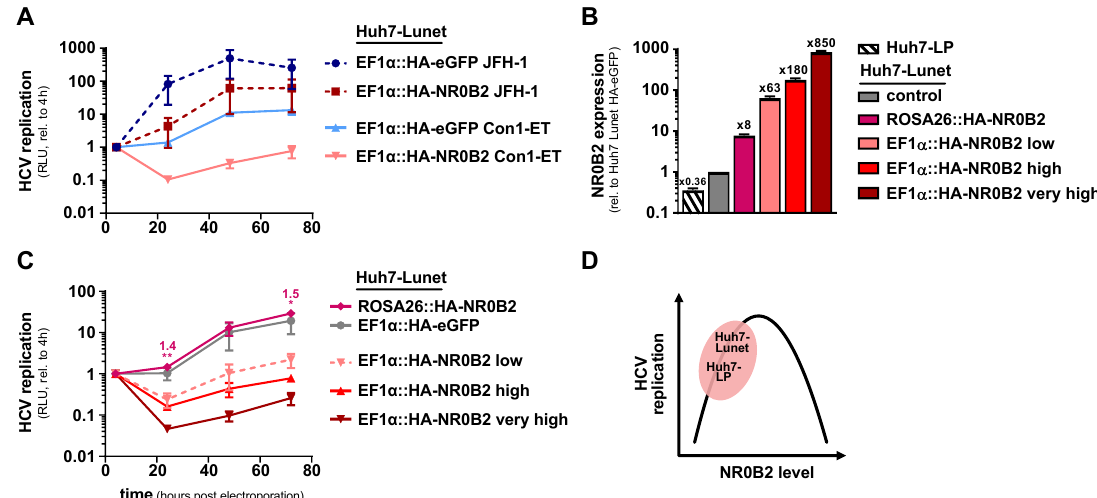
Figure 6. NR0B2 expression levels determine HCV replication e ffi ciency independent of the genotype. ( A ) Replication of subgenomic luciferase reporter replicons of gt2a (JFH-1) or gt1b (Con1-ET) after electro-transfection into Huh7-Lunet overexpressing HA-NR0B2 compared to an HA-eGFP expressing control in a time-course of 72 h. ( B ) Expression levels of Huh7-Lunet cells expressing di ff erent amounts of HA-NR0B2 compared to an HA-eGFP expressing control cell line by qRT-PCR. ( C ) Replication of a subgenomic luciferase reporter replicon (gt1b) after electro-transfection into Huh7-Lunet cells expressing di ff erent amounts of HA-NR0B2 compared to an HA-eGFP control in a time-course of 72 h. ( D ) Proposed model of the correlation between NR0B2 levels and HCV replication e ffi ciency in Huh7-Lunet and -LP cells. Luciferase data ( A , C ) is normalized to the input signal four hours post transfection and shows mean and standard deviation from at least three independent biological experiments. Significance was calculated using two-tailed, non-paired Student’s t -test. * p ≤ 0.05, ** p ≤ 0.005. DENV